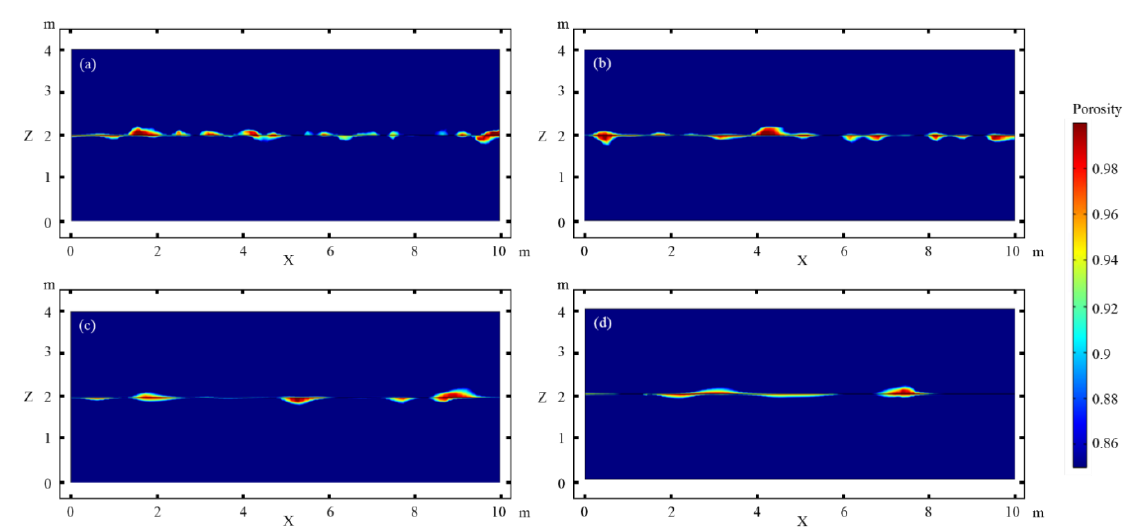
Figure 4. Effect of the characteristic length of the matrix porosity heterogeneity on the dissolution along the horizontal fracture. ( a – d ) represent the results for a characteristic length of 0.2, 0.33, 0.5, and 1.0, respectively.